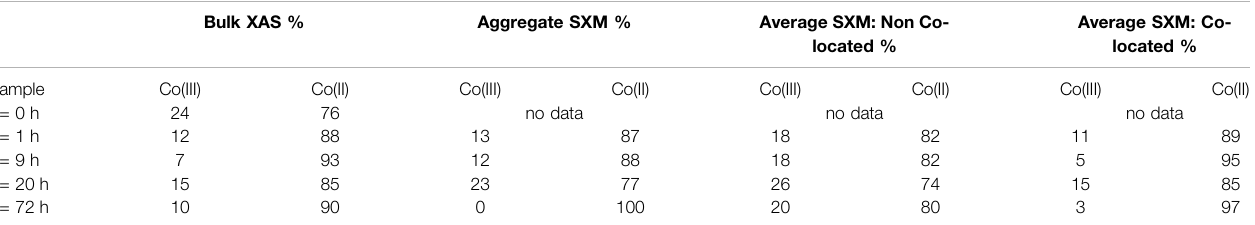
TABLE 2| SummaryofCospecies proportions from keytime points according tobest fi tsusingoctahedralmetal calculationforbulk L 2,3 -edgedataand averageSXM data points. Aggregate SXM, spectra of the entire area imaged and analysed. Bulk XAS % Aggregate SXM % Average SXM: Non Co-